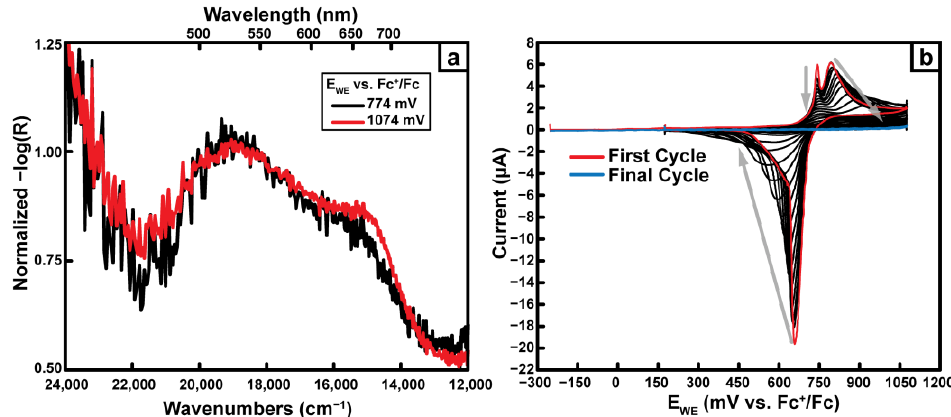
Figure 6. ( a ). Diffuse reflectance spectra of FTO working electrodes modified with adsorbed Pd(dppf)TPT following electrolysis at the indicated potential. Spectra are normalized to the 527 nm absorbance band of the native Pd(dppf)TPT species. ( b ). Cyclic voltammograms (50 total cycles) of 0.30 mM Pd(dppf)TPT in DCM (100 mM TBAPF 6 ) at a scan rate of 10 mV ∙ s −1 . Alternating cycles have been omitted for clarity.